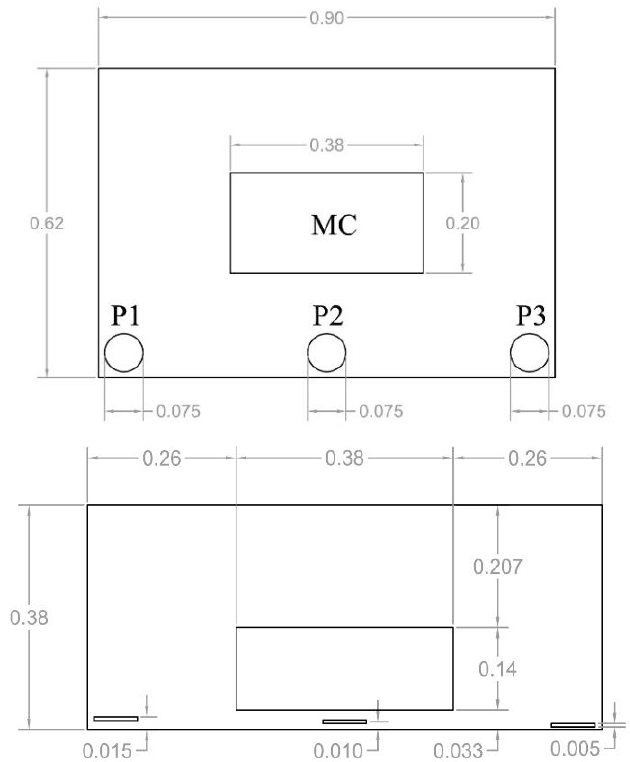
Figure 1. Vertical and horizontal sections of the concrete wall (dimensions are in meters).